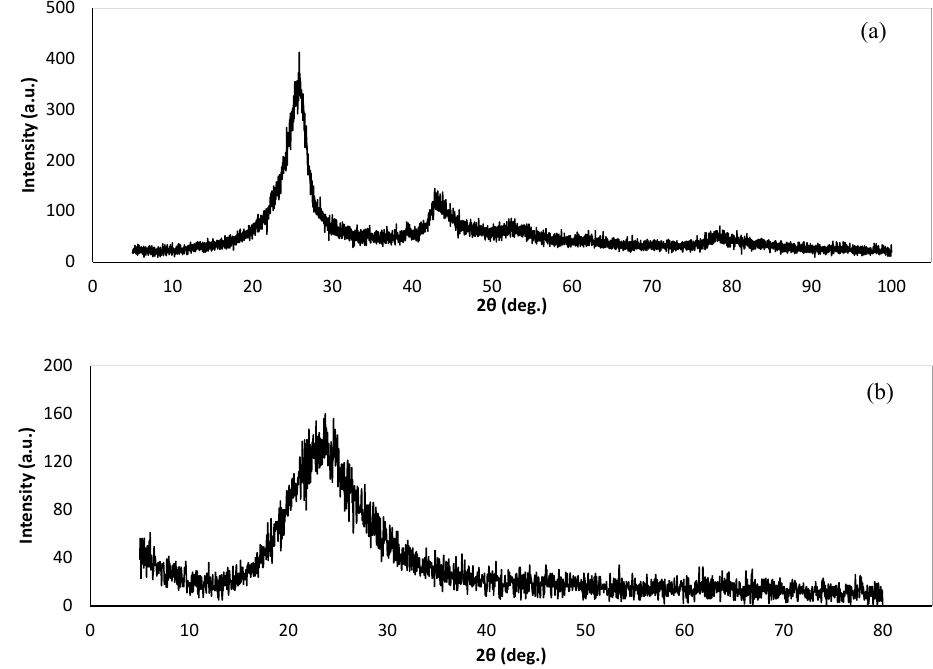
Figure 2. XRD diffraction pattern of: ( a ) CNT; and ( b ) SiO 2 nanoparticles.